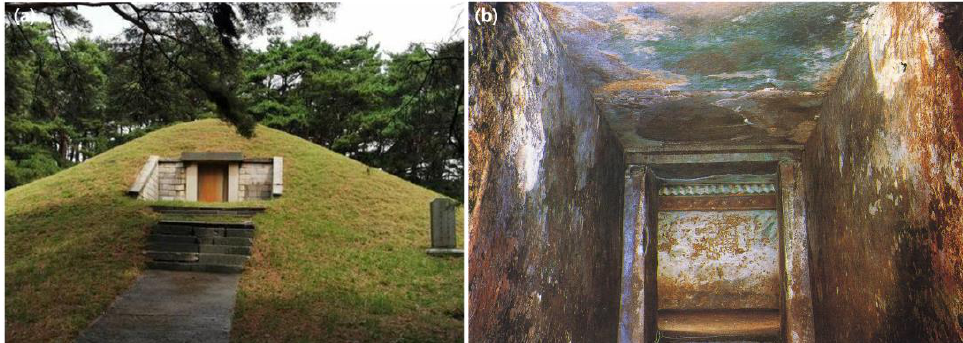
Figure 1. Overview of the Jinpari Tomb No. 4. ( a ) Outside [20]. ( b ) Inside.